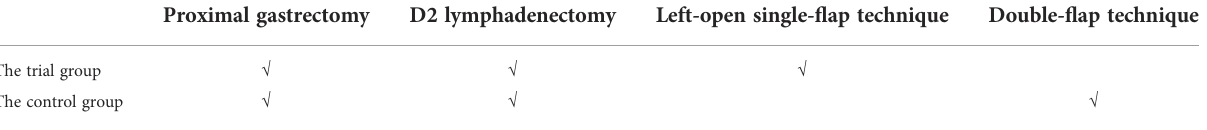
TABLE 1 Surgical methods applied in this